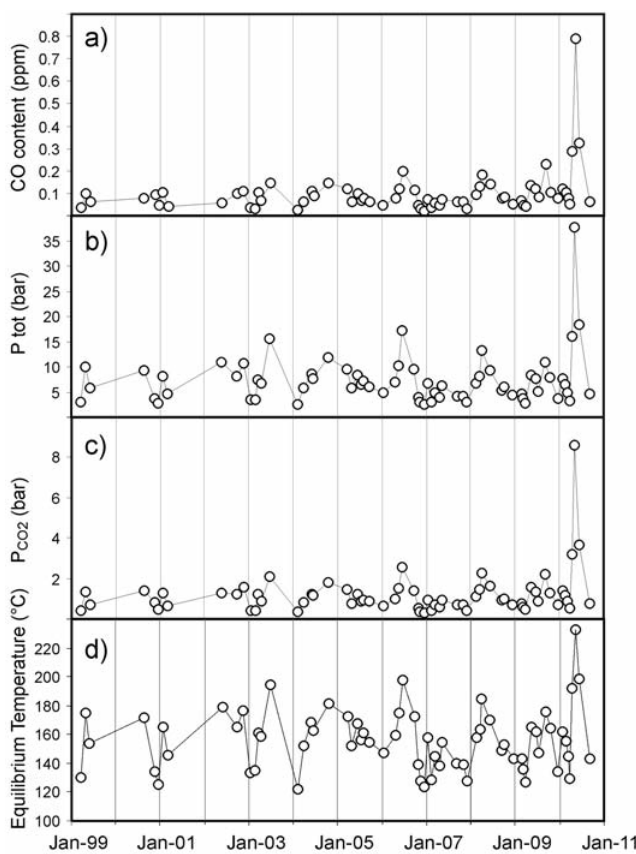
Figure 7. Chronograms of CO content (a), P equilibrium temperature (d) for the Pisciarelli fumarole. Seasonal effects affect the fumarolic CO content and consequently the T–P estimations. It is worth noting the peak CO contents and T–P estimates relative to summer 2010, when the values estimated approached those of the BG and BN fumaroles.